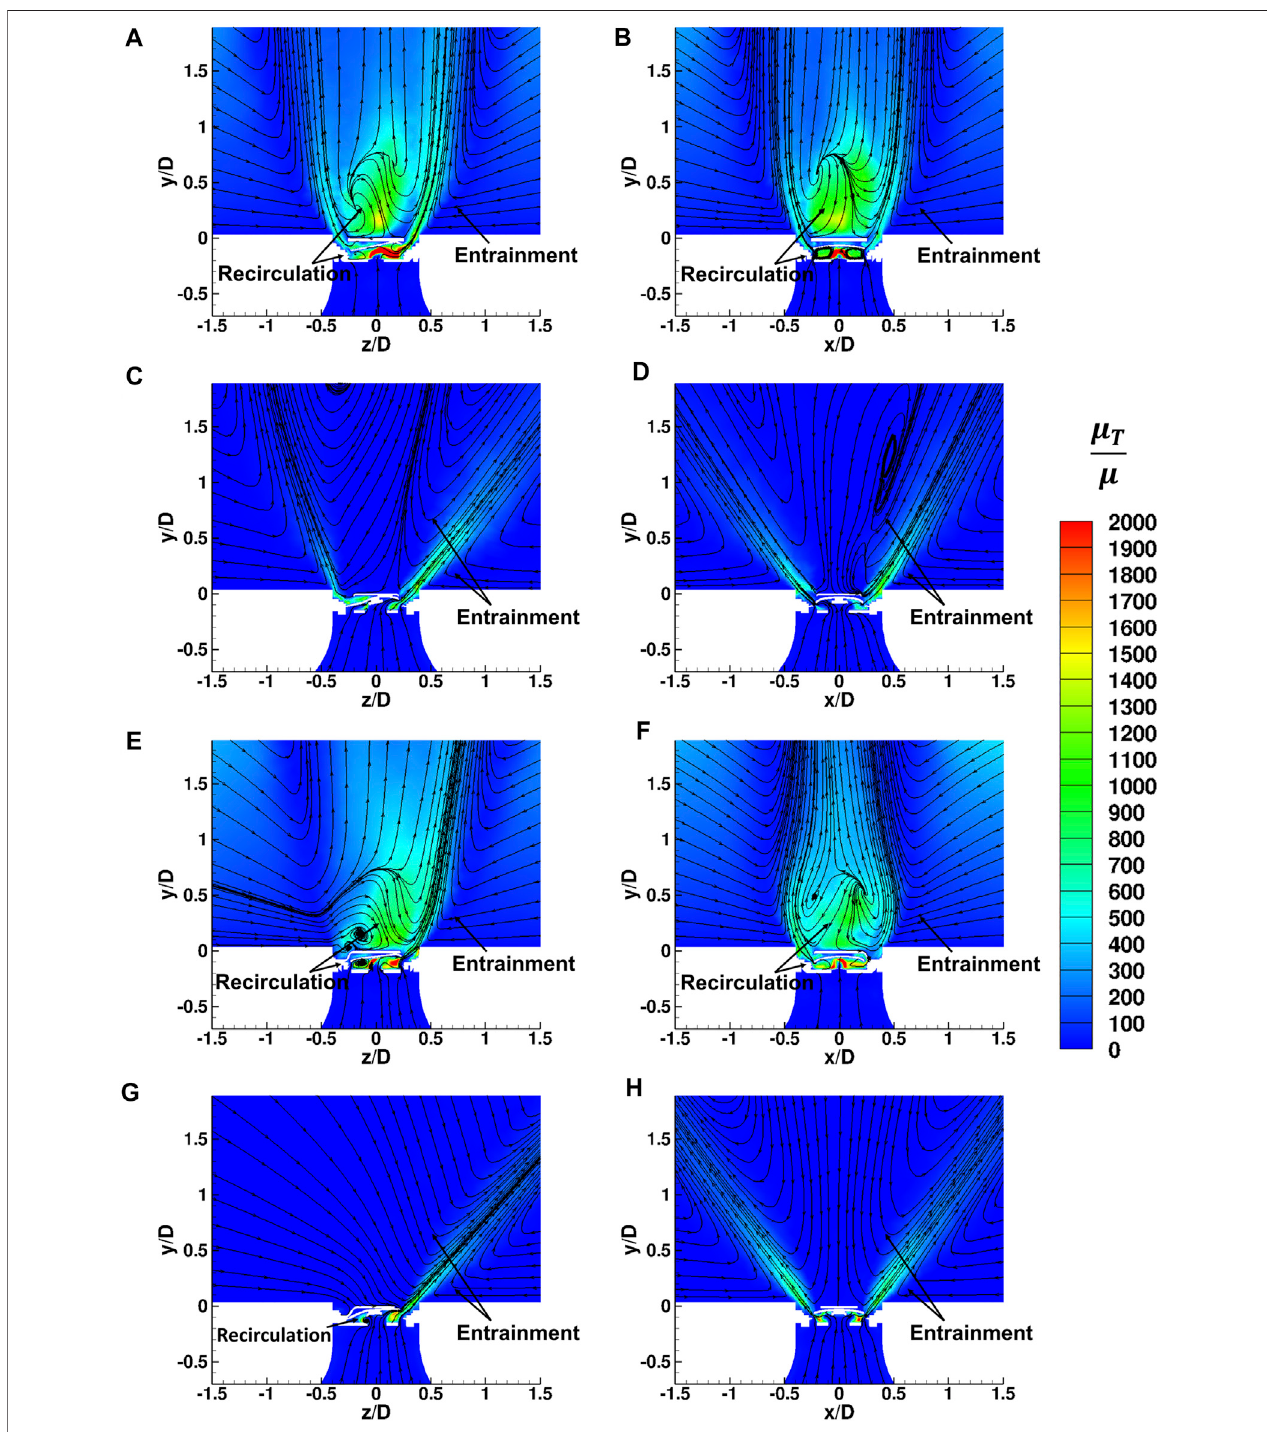
FIGURE 9 | RANS simulated turbulent viscosity ratio distribution at P 1 /P 2 (cid:1) 7, in the x-normal (left) and z-normal (right) cross-sectional planes for each LIB cap: MTI (A) and (B) , LG MJ1 (C) and (D) , K2 (E) and (F) , and LG M36 (G) and (H) .